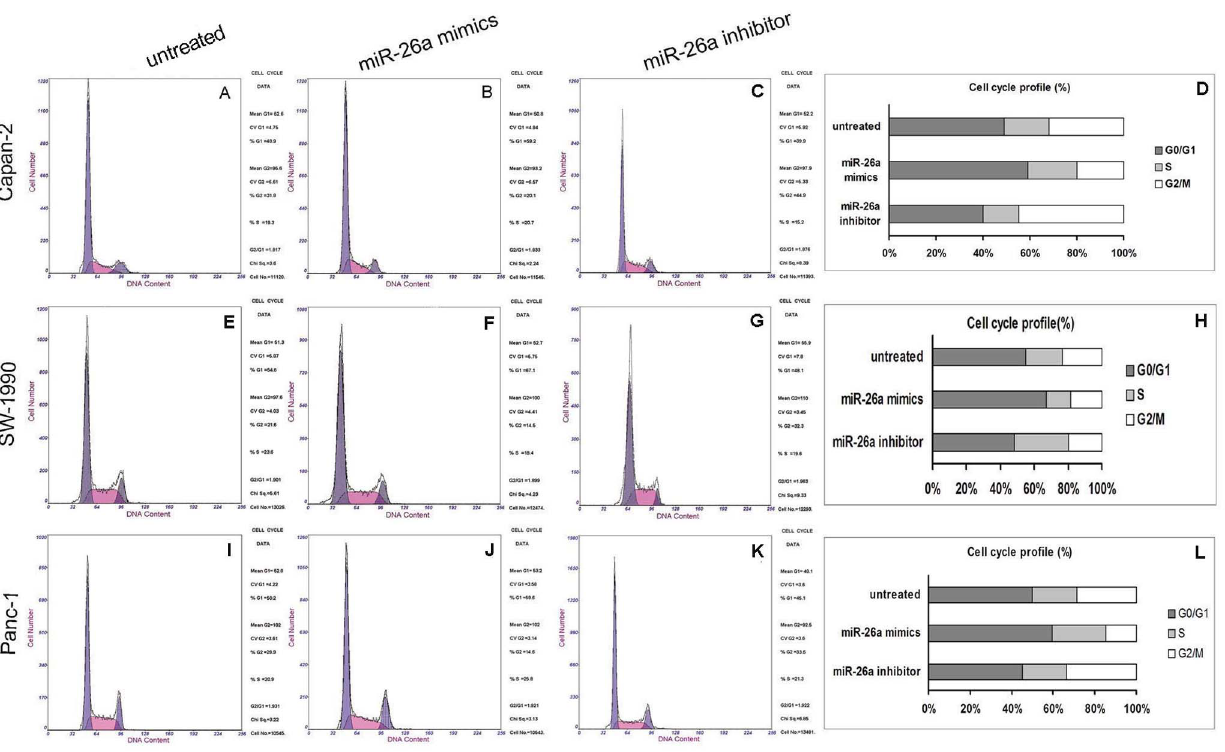
Figure 4. Representation of cell cycle distribution in Capan-2 (A,B,C), SW-1990 (E,F,G), and Panc-1 (I,J,K) cells. Cells were either transfected with miR-26a mimics or inhibitors. The controls were left untreated. D, H, and L indicate the statistical cell cycle distribution for Capan-2, SW-1990, and Panc-1, respectively.